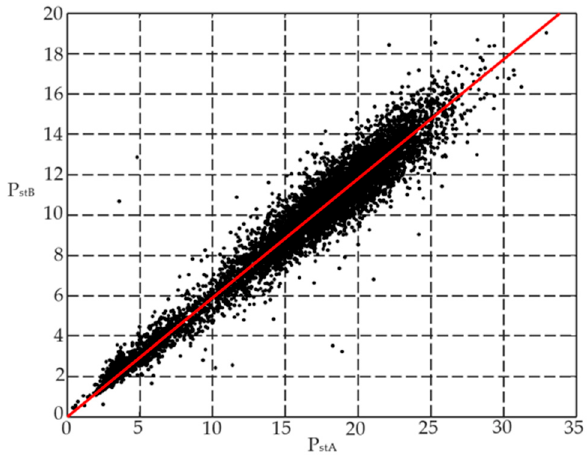
Figure 8. Graph of relationship between indicators of P st measured at point B and those measured at point A, and the approximating line. point A, and the approximating